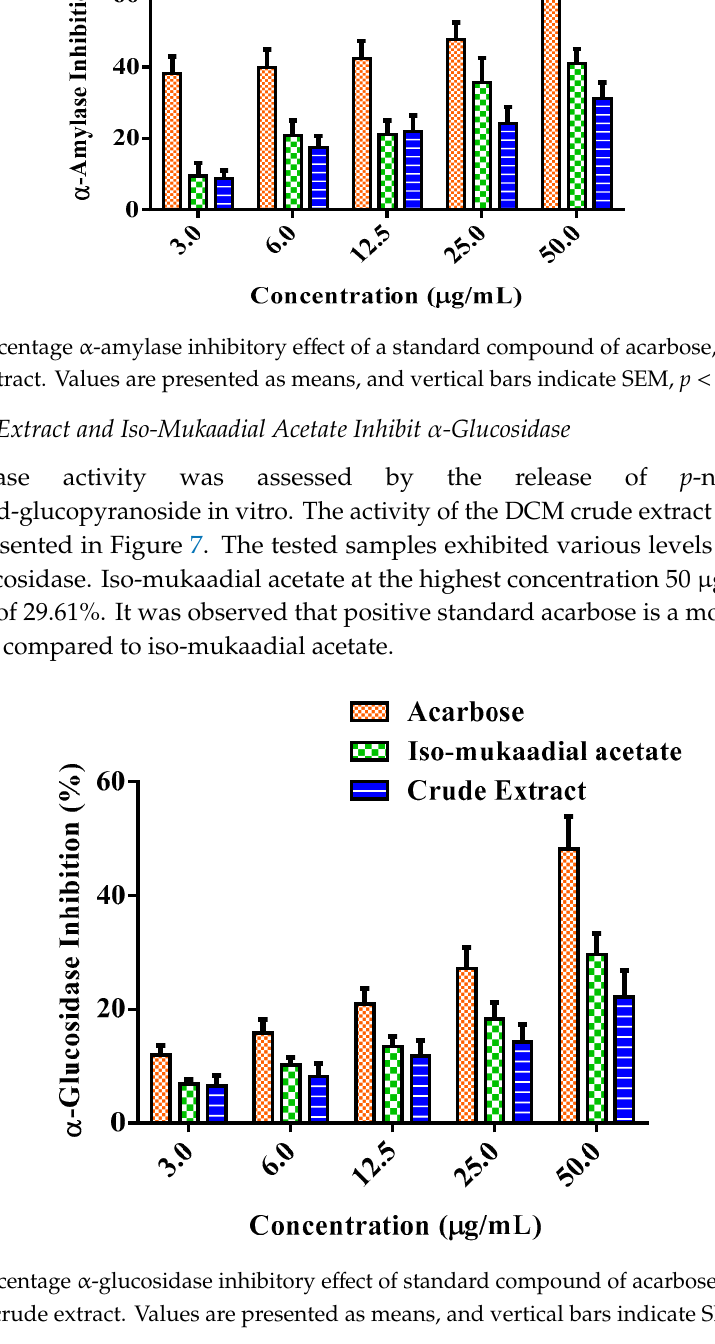
Figure 5. The effect of iso-mukaadial acetate and crude extract on AMP-activated protein kinase (AMPK) protein expression in L6 skeletal muscle cells. Results are expressed as mean ± SEM of three independent experiments. Levels of significance * p < 0.05, ** p < 0.01 versus, Iso 3: iso-mukaadial acetate 3 µg/mL, Iso 6: iso-mukaadial acetate 6 µg/mL, Iso 12: iso-mukaadial acetate 12.5 µg/mL, Crude 3: crude extract 3 µg/mL and Crude 6: crude extract 6 µg/mL.